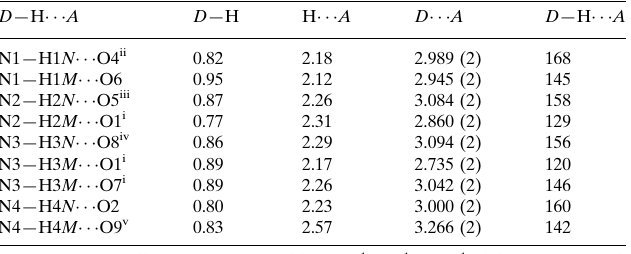
Hydrogen-bond geometry (A˚ , (cid:3)